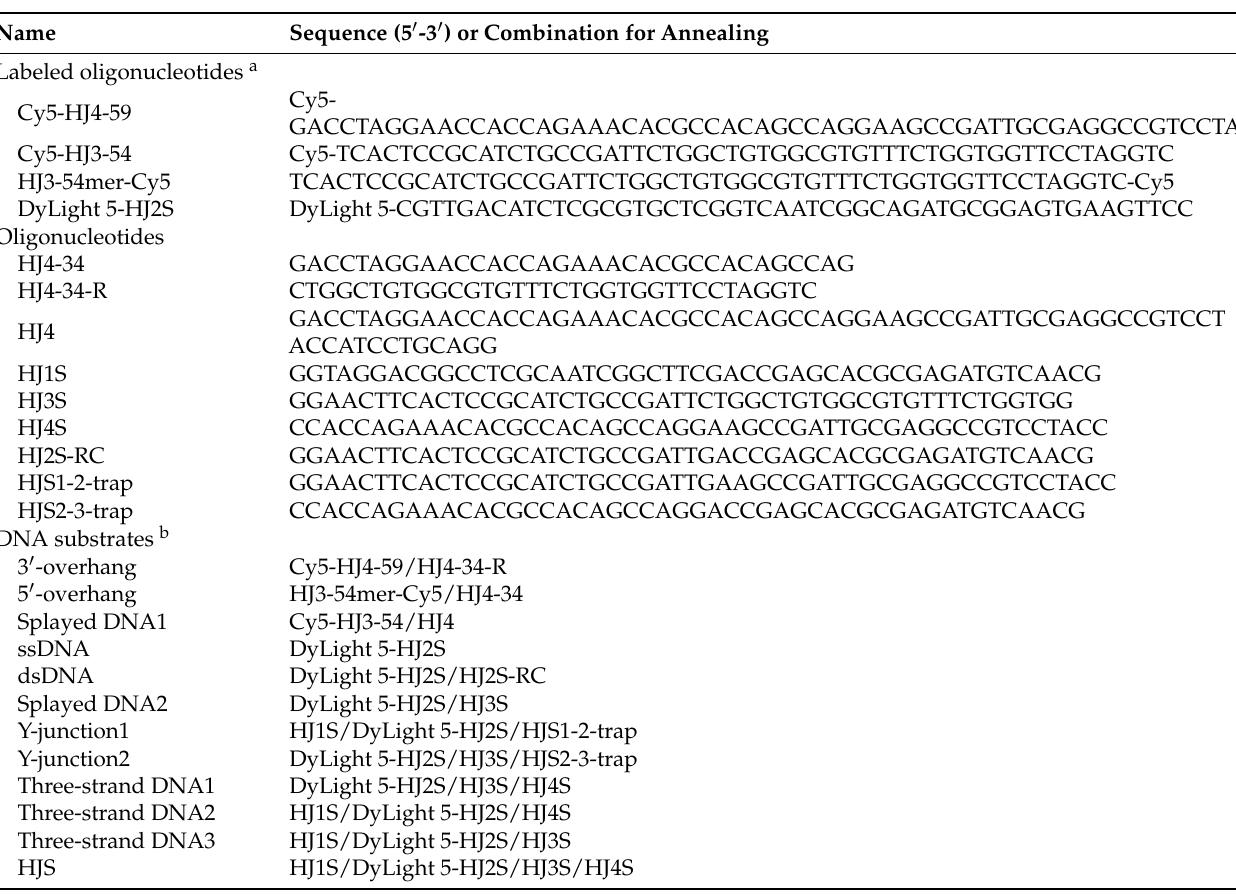
Table 2. Substrates and trap DNAs used in this